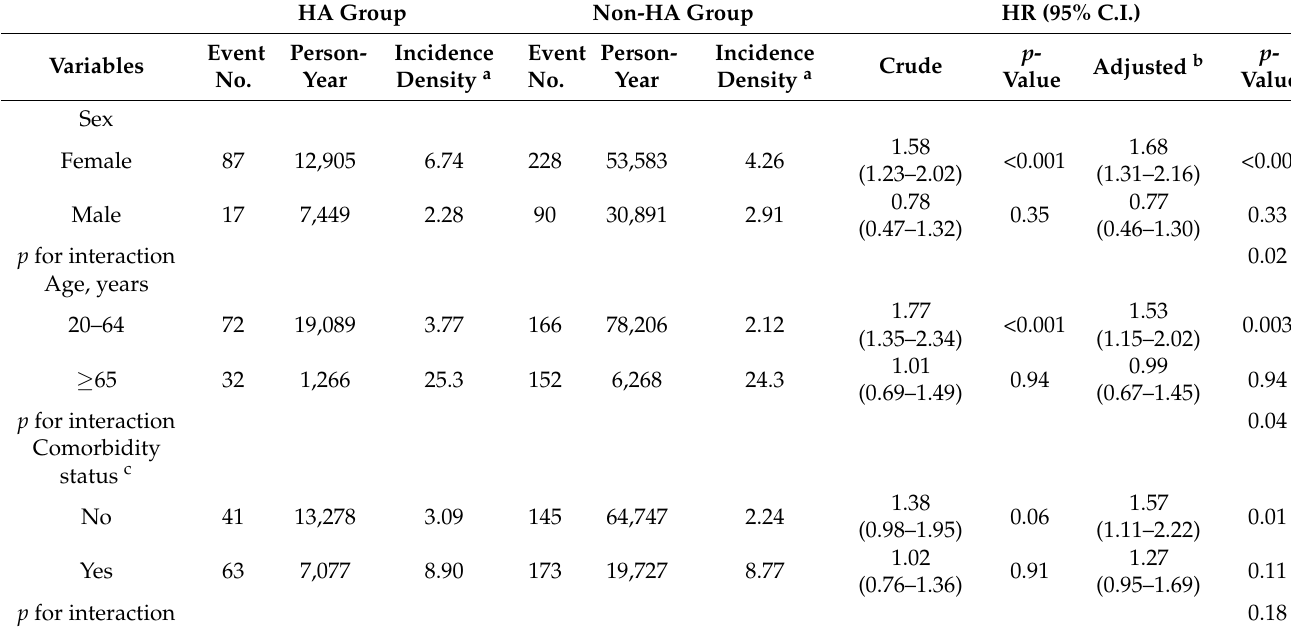
Table 3. Incidence density and hazard ratios of osteoporosis according to hemolytic anemia status stratified by sex, age, and